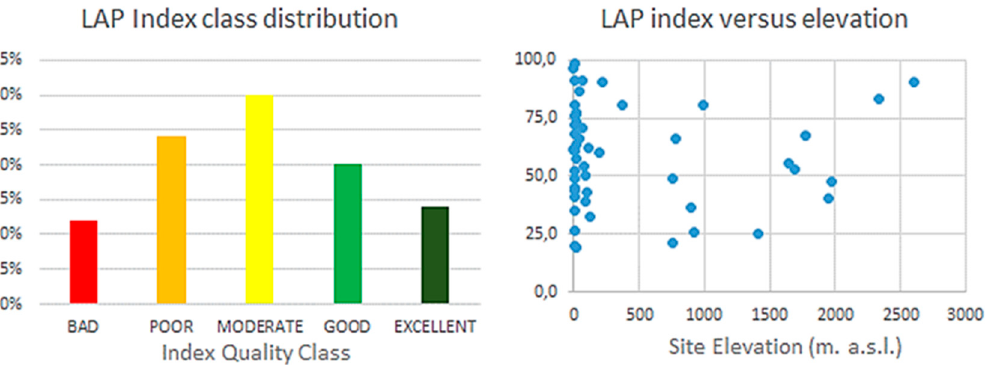
Figure 5. General results and distributions of the LAP survey. Left : Summary of final LAP index class assessments. Right : LAP index scores and elevation; no statistical significance existed for the relation of LAP ( Y -axis) versus elevation ( X -axis).